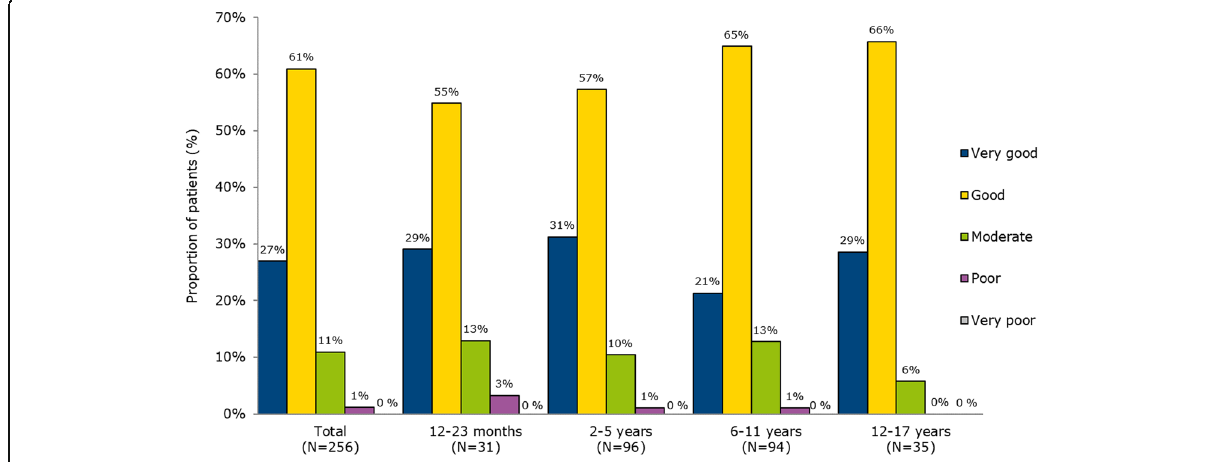
Fig. 7 Investigators assessment of effectiveness at visit 2